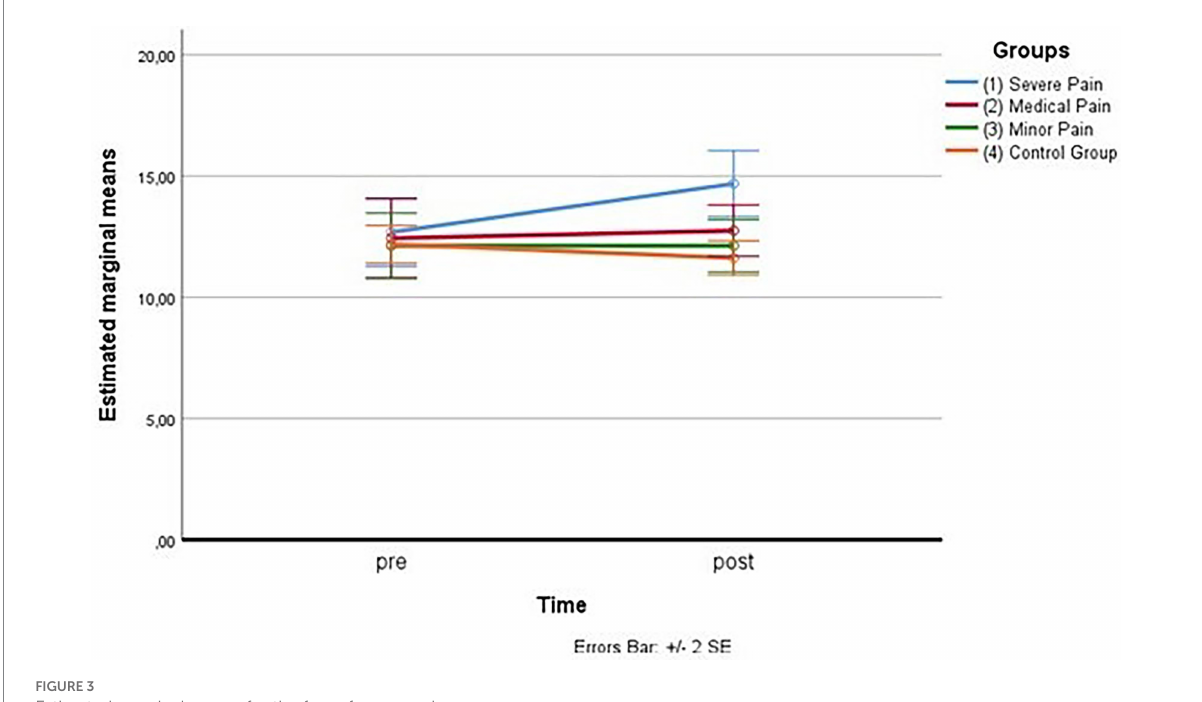
FIGURE 3 Estimated marginal means for the fear of severe